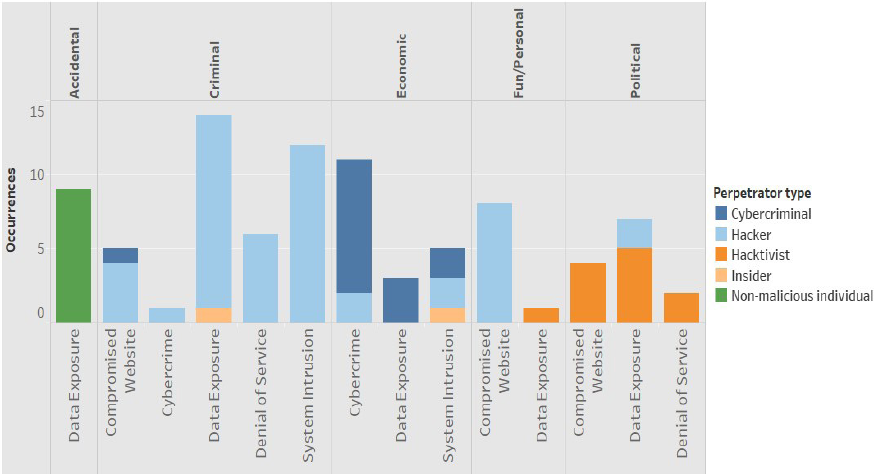
Figure 10: Relationships between incident type, perpetrator type, and